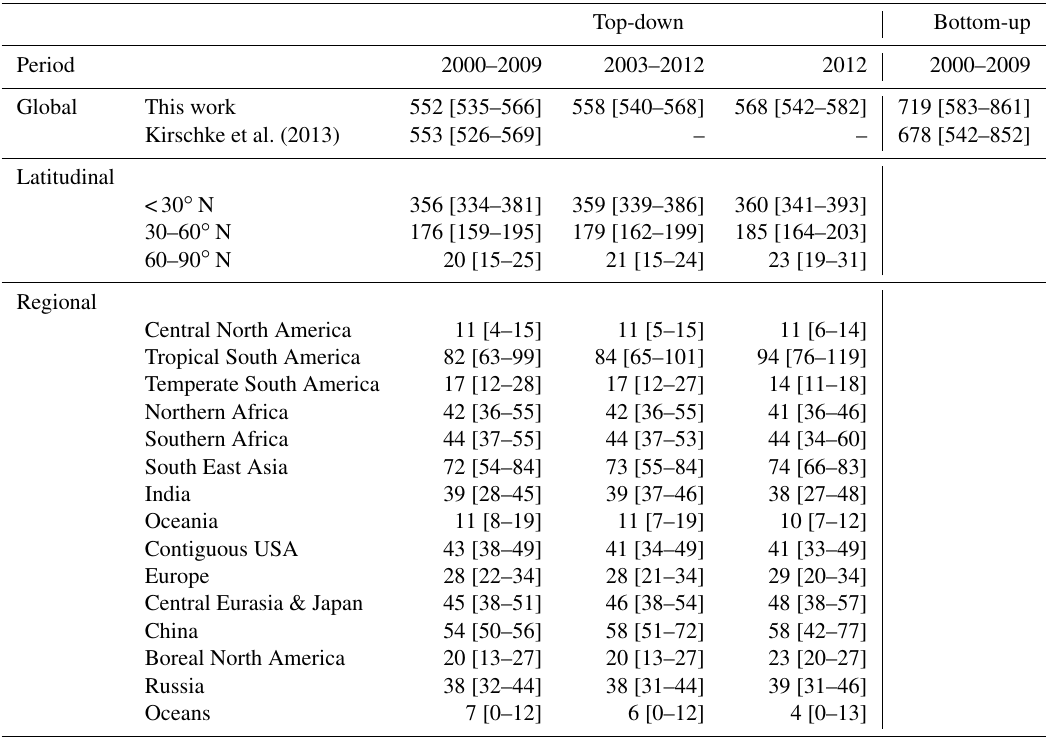
Table 4. Global, latitudinal and regional methane emissions in TgCH 4 yr − 1 , as decadal means (2000–2009 and 2003–2012) and for the year 2012, for this work using top-down inversions. Global emissions are also compared with Kirschke et al. (2013) for top-down and bottom-up for 2000–2009. Uncertainties are reported as [min–max] range of reported studies. Differences of 1TgCH 4 yr − 1 in the totals can occur due to rounding